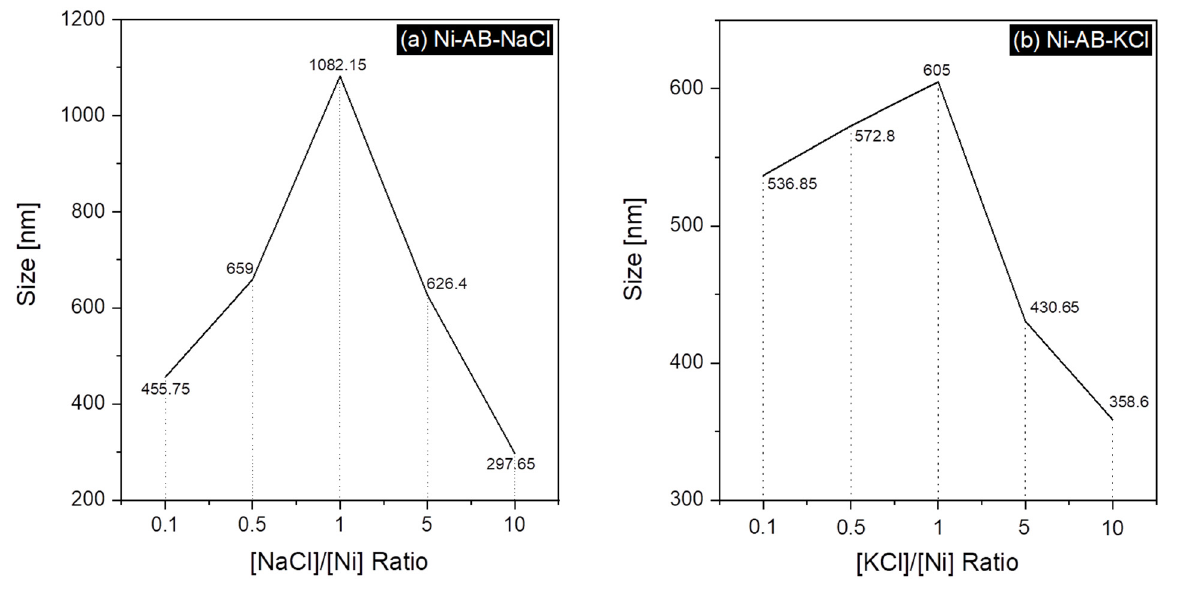
Figure 8. Particle size distribution of Ni nanoparticles with different concentrations of ( a ) NaCl or ( b ) KCl as an additive, respectively.